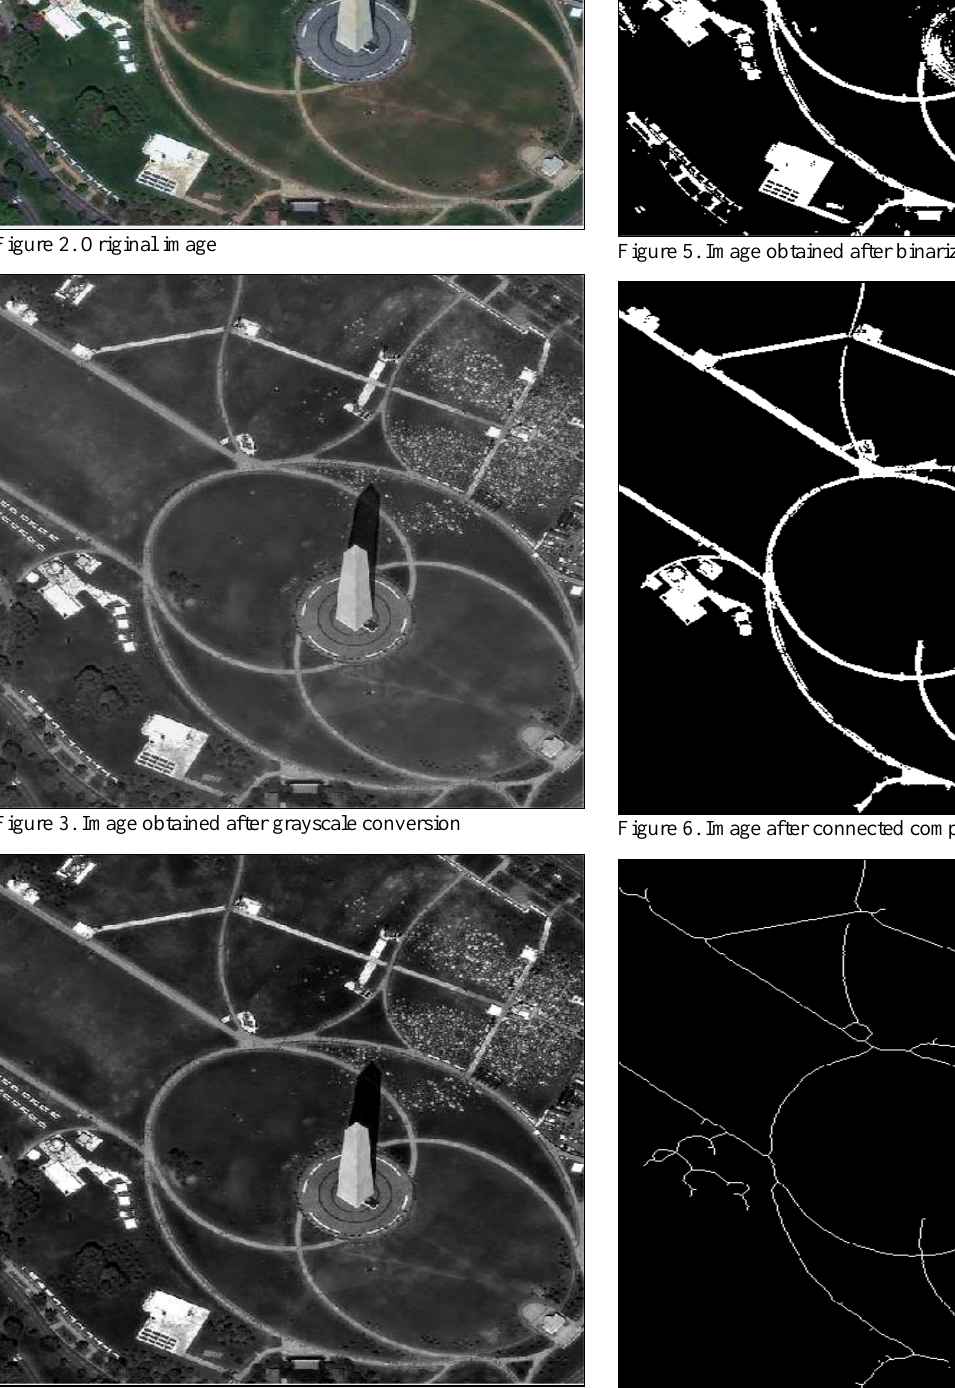
Figure 4. Image obtained after performing histogram equalization on grayscale image